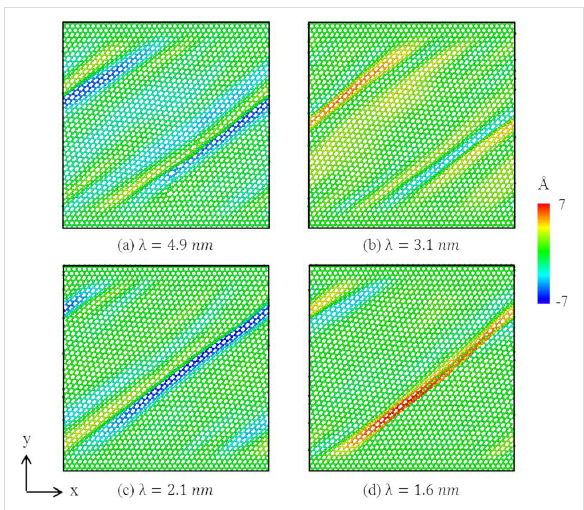
Figure 12: The out-of-plane displacement of zigzag graphene with dif- ferent repeat layer